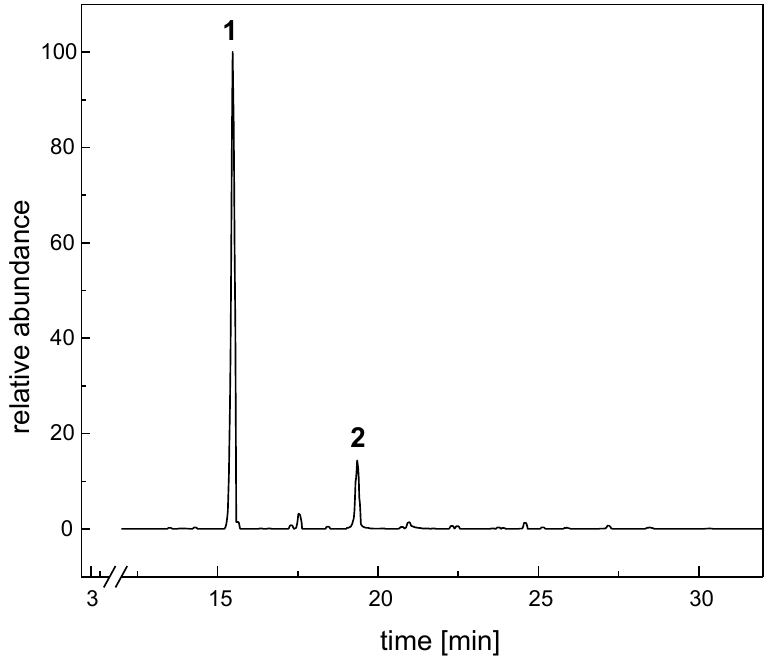
Figure 1. Gas chromatogram of the labial gland extract of B. ruderatus